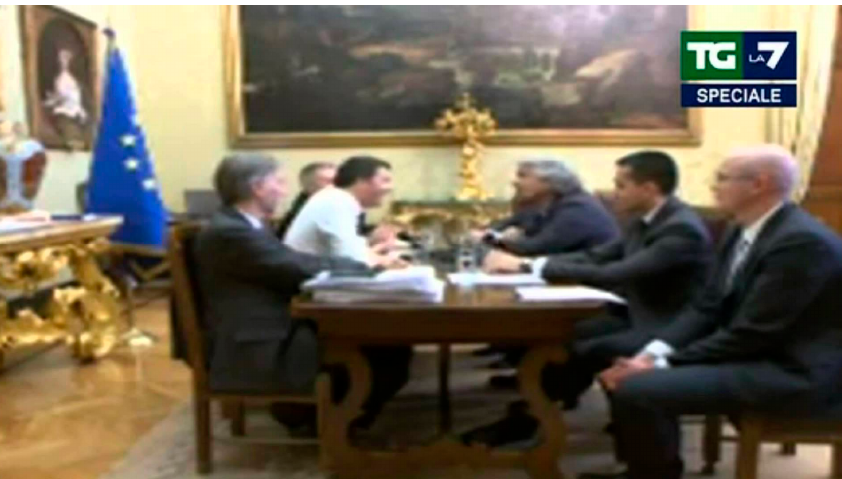
Figure 2. Frame from the direct stream documenting the consultations between Matteo Renzi and Beppe Grillo to form the government, 19 February 2014. (Available at: https://www.youtube. com/watch? v=4Sm6dF_moqc, last accessed: 21 August